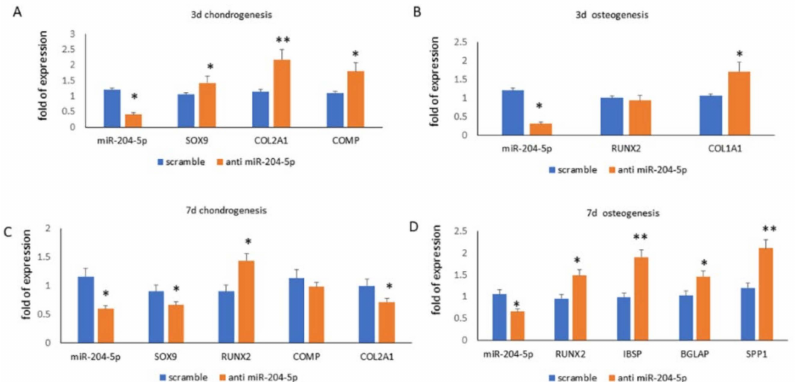
Figure 4. miR-204-5p, chondrogenic (SOX9, COL2A1, COMP, RUNX2) and osteogenic (RUNX2, COL1A1, IBSP, BGLAP, SPP1) mRNA expression levels quantified by RT-PCR during the early (( A , B ) 3 days) and the middle (( C , D ) 7 days) differentiation phases in miR-204-5p-silenced MSCs. (* p < 0.05; ** p < 0.005 vs. scramble/control).